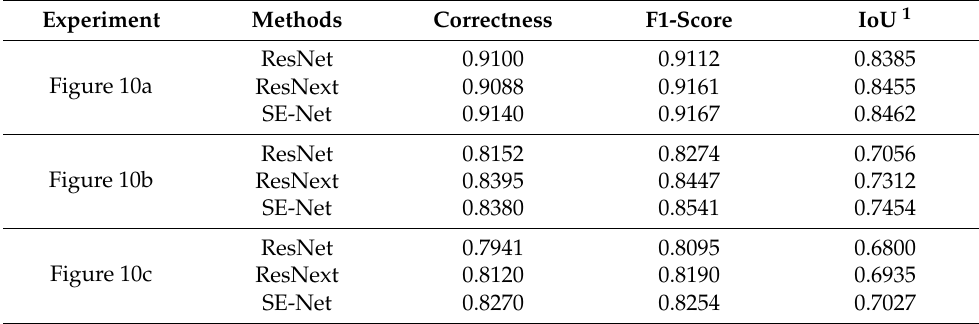
Table 3. Quantitative comparison of three backbone networks for the testing